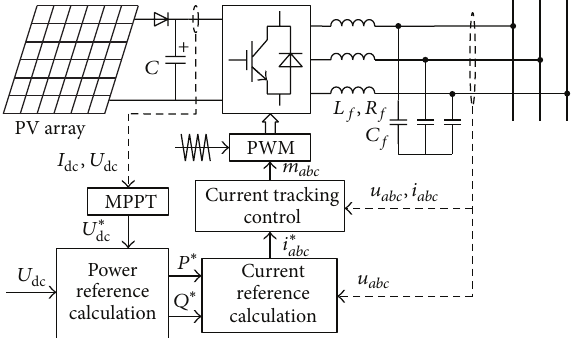
Figure 1: Grid-connected PV generation system